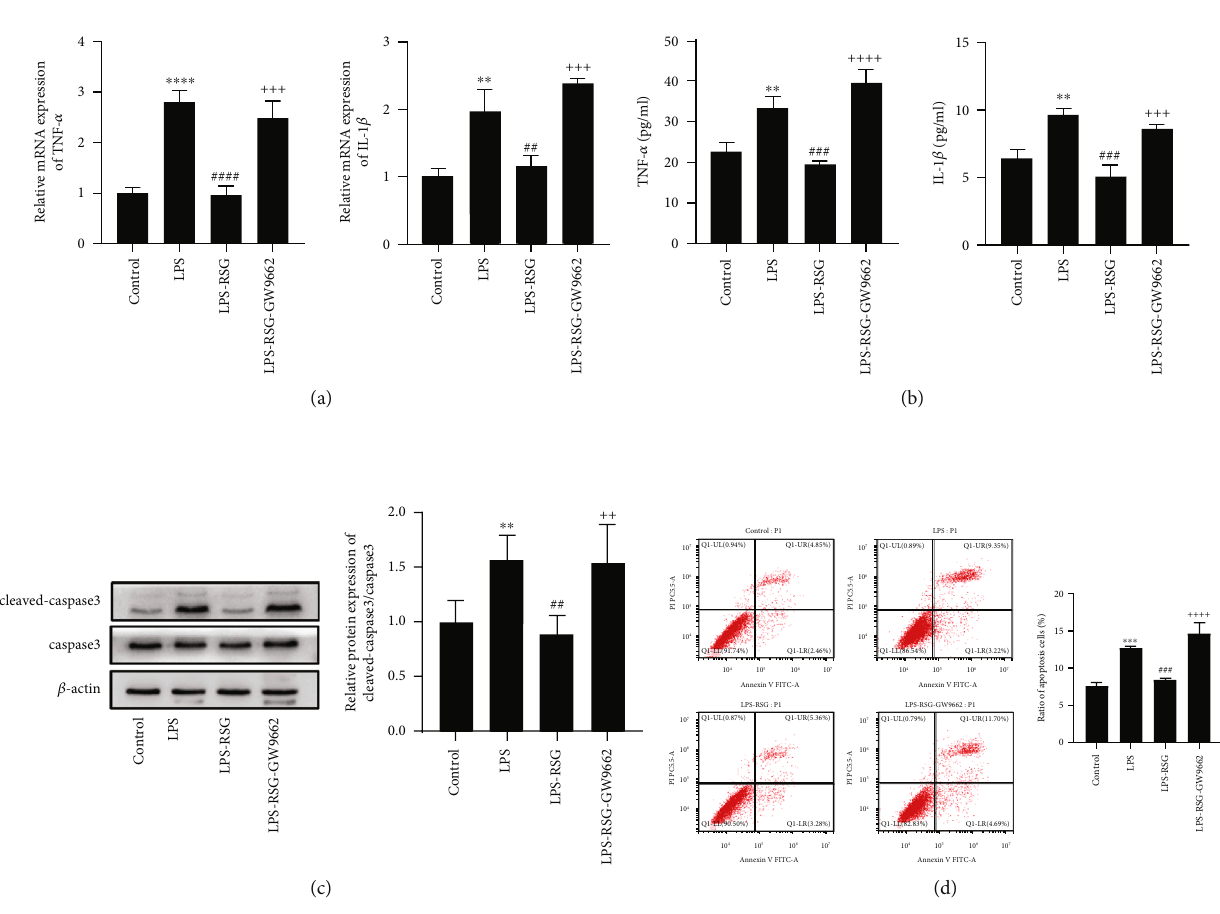
Figure 2: Activation of PPAR γ attenuated LPS-induced apoptosis and in fl ammation in alveolar epithelial cells. (a) Relative mRNA expressions of TNF- α and IL-1 β in A549 epithelial cells; (b) Levels of TNF- α and IL-1 β in cell culture supernatants; (c) Western blotting and relative protein expression of cleaved-caspase3/caspase3 in A549 alveolar epithelial cell (cleaved-caspase3 was an activated form of caspase3); and (d) fl ow cytometry was used to detect the apoptosis of A549 alveolar epithelial cells and the percentage of apoptosis of A549 alveolar epithelial cells. Data are presented as mean ± SD . ∗∗ p < 0 : 01 , ∗∗∗ p < 0 : 001 , ∗∗∗∗ p < 0 : 0001 vs. Control, ## p < 0 : 01 , ### p < 0 : 001 , #### p < 0 : 0001 vs. LPS, +++ p < 0 : 001 , ++++ p < 0 : 0001 vs.